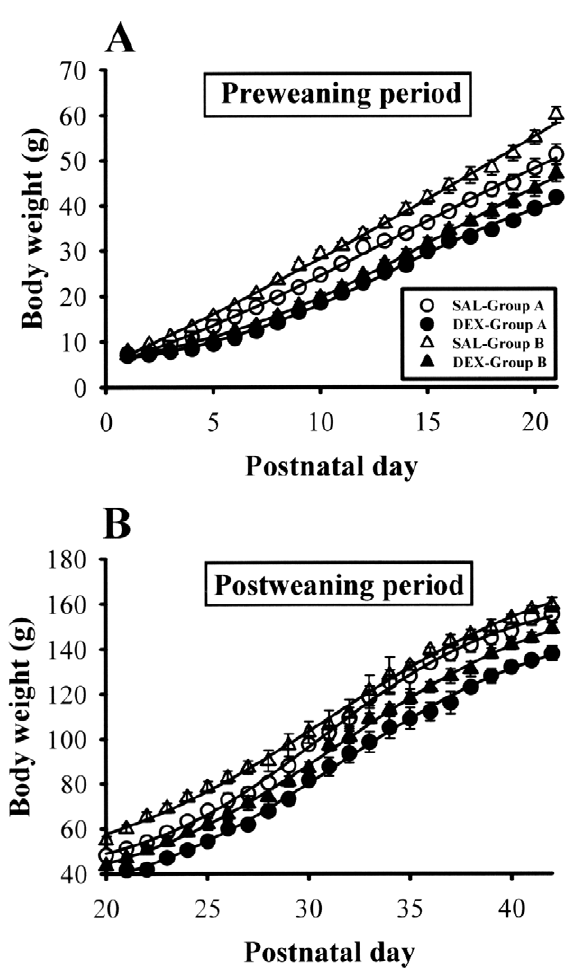
Figure 1. Effect of neonatal DEX treatment on body weight. (A) DEX-treated rats had significantly lower body weights compared with SAL-treated rats at most ages during the preweaning period (P1-P21) for Group A (8 pups/litter) and Group B (4 pups/litter). (B) DEX-treated rats weighted significantly less than SAL-treated rats during the postweaning period (P22-P42) for Group A and Group B. Data represent the mean 6 SEM (n=10 for each group).